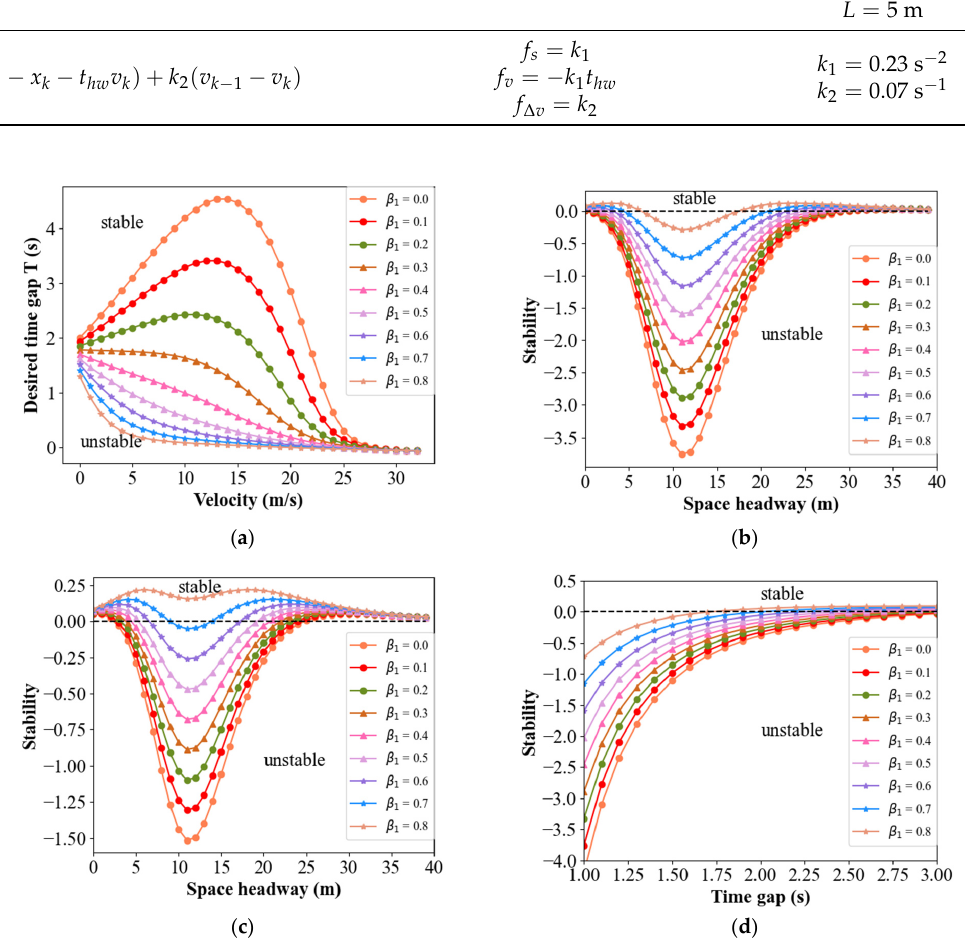
Figure 3. Relationship between the string stability of the traffic and β 1 under the BDVIS for four models. ( a ) Stability curves of traffic in IDM under the BDVIS; ( b ) Stability curves of traffic in FVD under the BDVIS; ( c ) Stability curves of traffic in OV model under the BDVIS; ( d ) Stability curves of traffic in ACC model under the BDVIS.